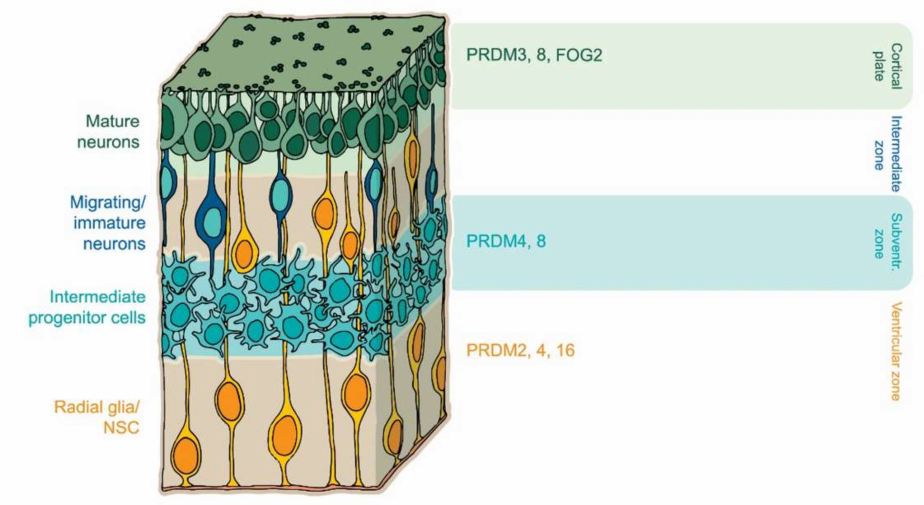
Figure2. PRDMfactorsplaymultiplerolesduringcentralnervoussystem(CNS)development. PRDM16 controls the migration and di ff erentiation of neuronal progenitors during cortical development [24,25]. FOG2 arranges a neuronal subtype identity [93] whereas PRDM8 controls axonal targeting